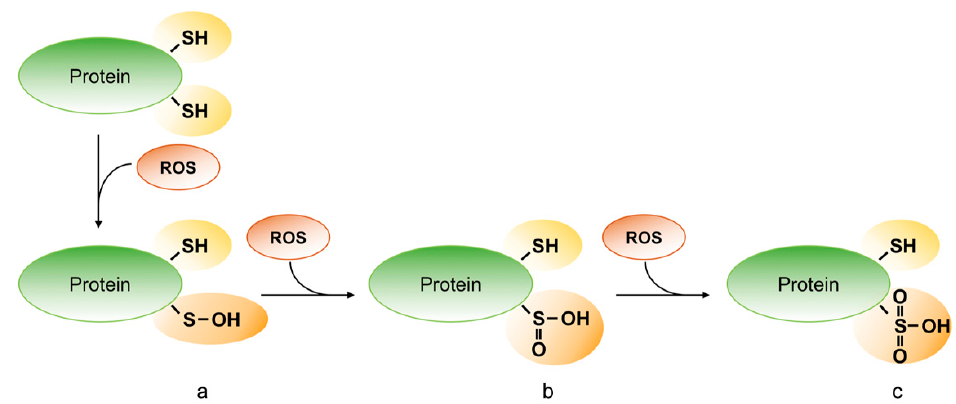
Figure 6. Oxidative modifications of protein thiols. Reactive oxygen species (ROS) can oxidize the protein on the thiol group of cysteine residues and can generate sulfenic (R-SOH) ( a ), sulfinic (R-SO 2 H) ( b ) and sulfonic acid (R-SO 3 H) ( c ).